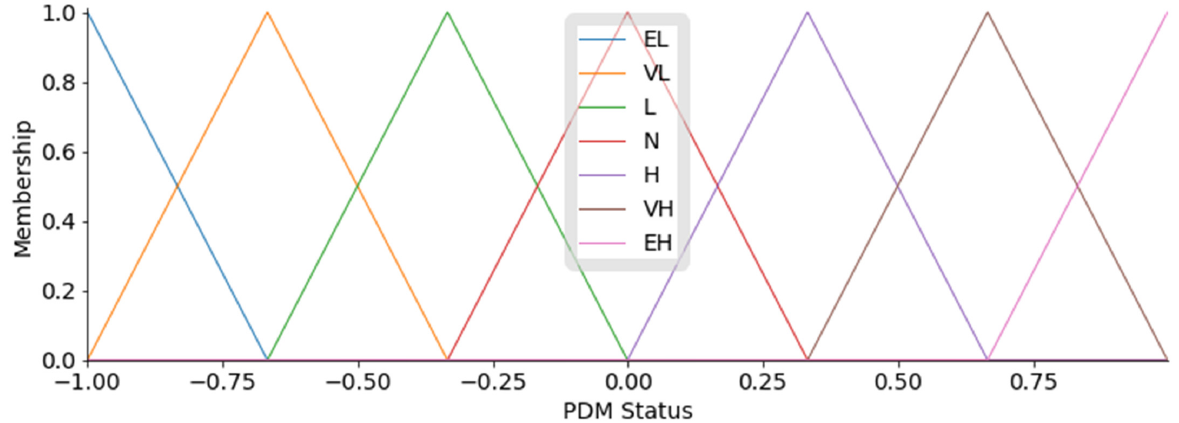
Figure 7. Graphical description of variable PDM Status. Table 4. Membership functions for variable PDM